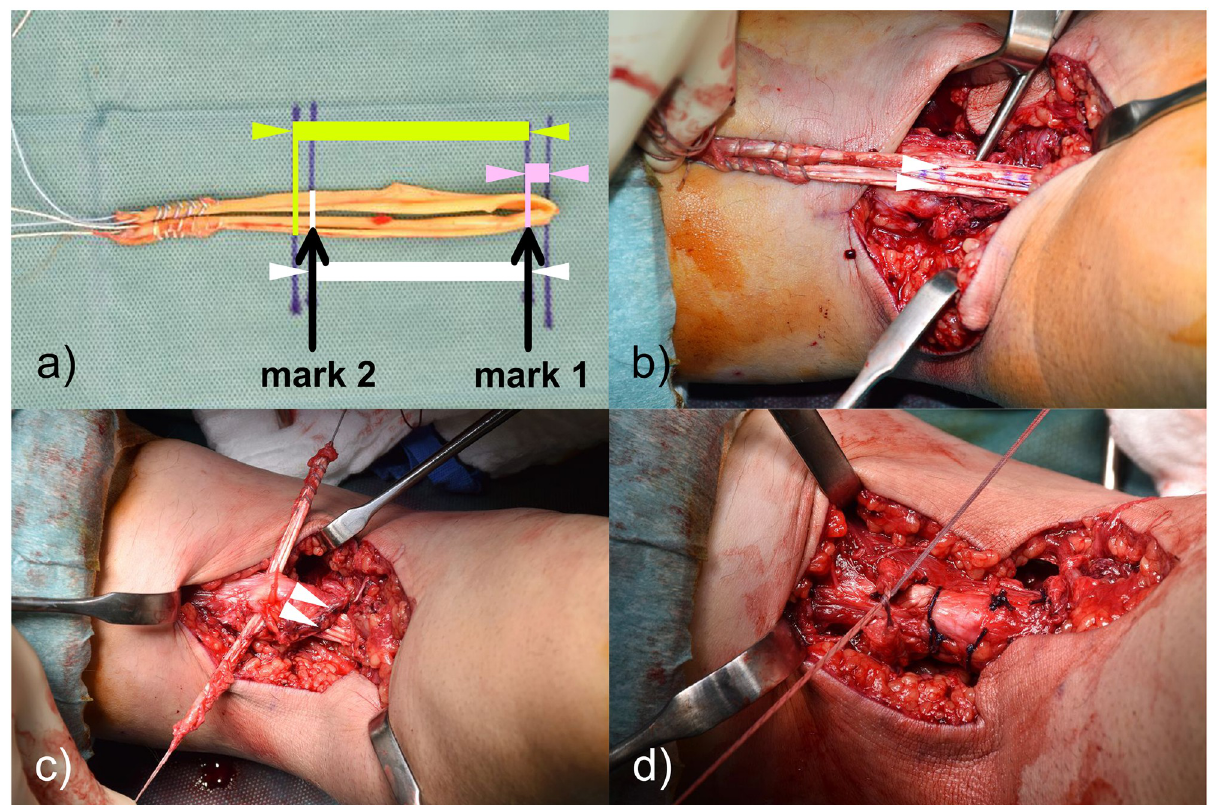
Fig 8. Intraoperative pictures of graft interposition with a hamstring autograft. a) Green = calculated tendon length, White = calculated tendon length without remaining tendon stump, Pink = intraosseous distance of 0.5cm. Mark 1 = corresponding to intraosseous distance, Mark 2 = corresponding to calculated tendon length without remaining tendon stump. b) The arm is flexed, mark 2 visible. c) Tendon length adjustment. d) Interwave of the